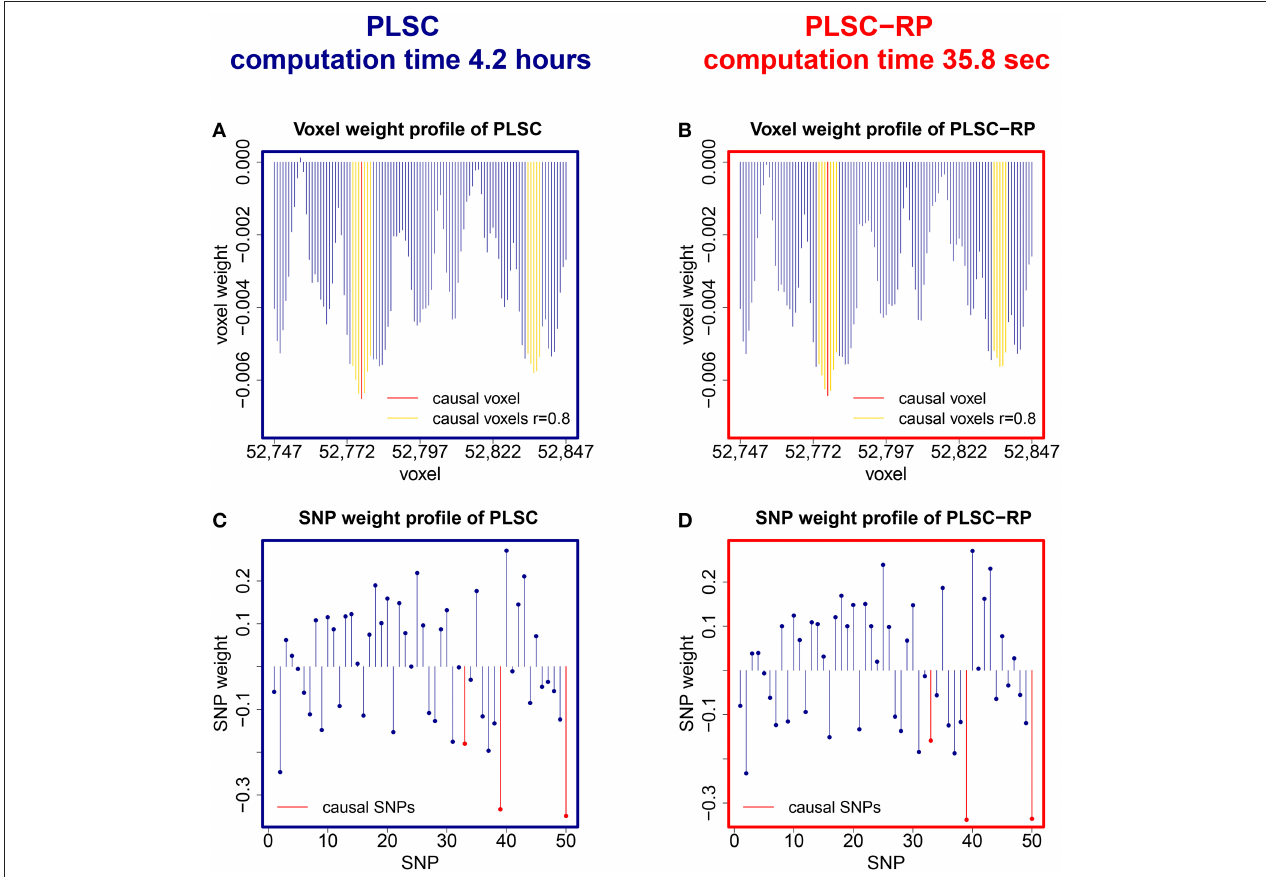
FIGURE 1 | PLSC and PLSC-RP weights for high-dimensional neuroimaging data. (A) Voxel weight profile and (C) SNP weight profile of the causal PLSC component for 90,000 simulated voxels. (B) Voxel weight profile and (D) SNP weight profile of the causal PLSC-RP component after dimensionality reduction of the fMRI data set to 100 dimensions. PLSC and PLSC-RP provide a weight for each voxel and each SNP. The causal voxel and causal SNPs (red), and voxels in collinearity with the causal voxel (yellow), receive higher weights than non-causal voxels and SNPs (blue). For visualization purpose, the voxel weight profiles of PLSC and PLSC-RP (A,B) are zoomed in on a range of 100 voxels around the causal voxel.